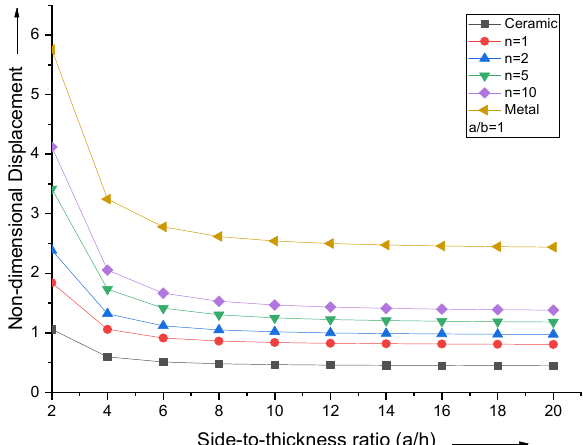
Figure 4. Effect of side − to − thickness ratio (a/h) on non − dimensional central deflection of the plate. When the volume fraction index is varied, the non-dimensional normal stress curves attain the extremum near the top and bottom surfaces of the FGM plate, as shown in Fig- ure 5. The neutral axis plane shifts towards the top metallic portion for lower values of n and then comes back to midplane for higher n values.